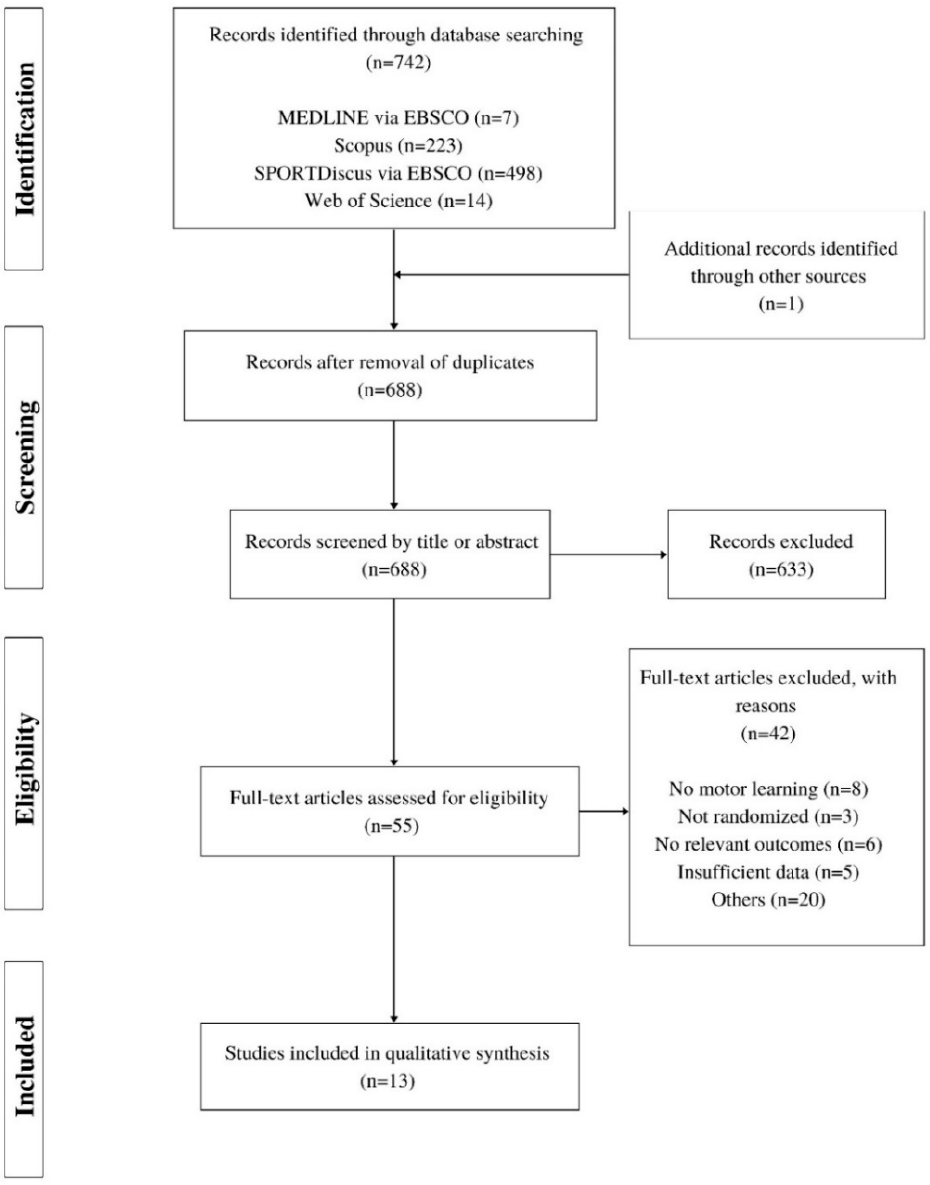
Figure 1. Flow chart of the study selection process.